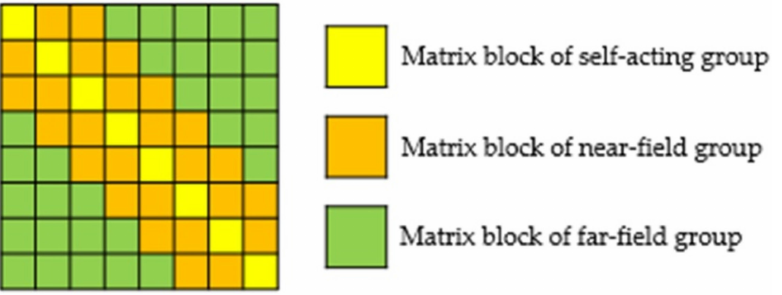
Figure 6. Matrix block diagram.